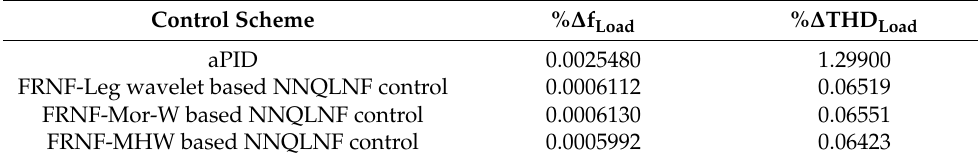
Table 3. Average values of % ∆ f Load and % ∆ THD Load variation in load current for all controllers.